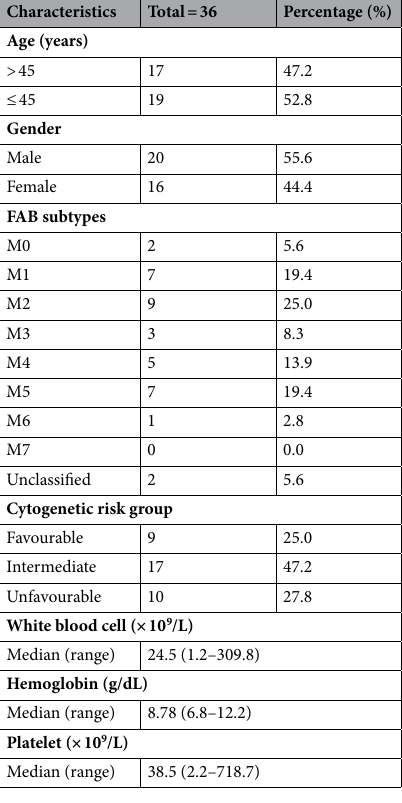
Table 1. Clinical characteristics of 36 cases of acute myeloid leukemia patients. FAB French–American– Britain.